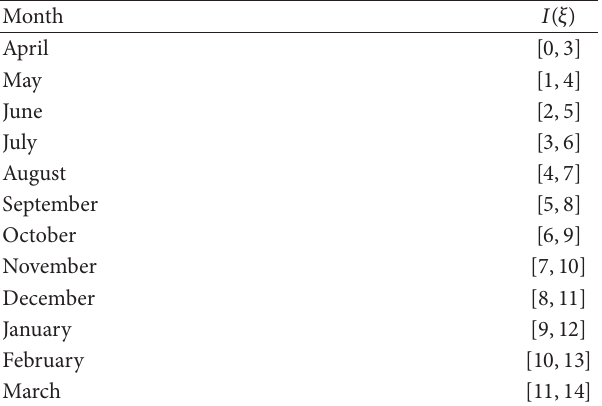
Table2:Inthefirstcolumn,wehavethemonthsofelectricitysupply of the peak contracts considered, while in the next five columns we have the mean absolute percentage errors (MAPE) obtained in the forecasts of the contracts value at 1,2,3, 4 , and 5 days ahead, respectively.